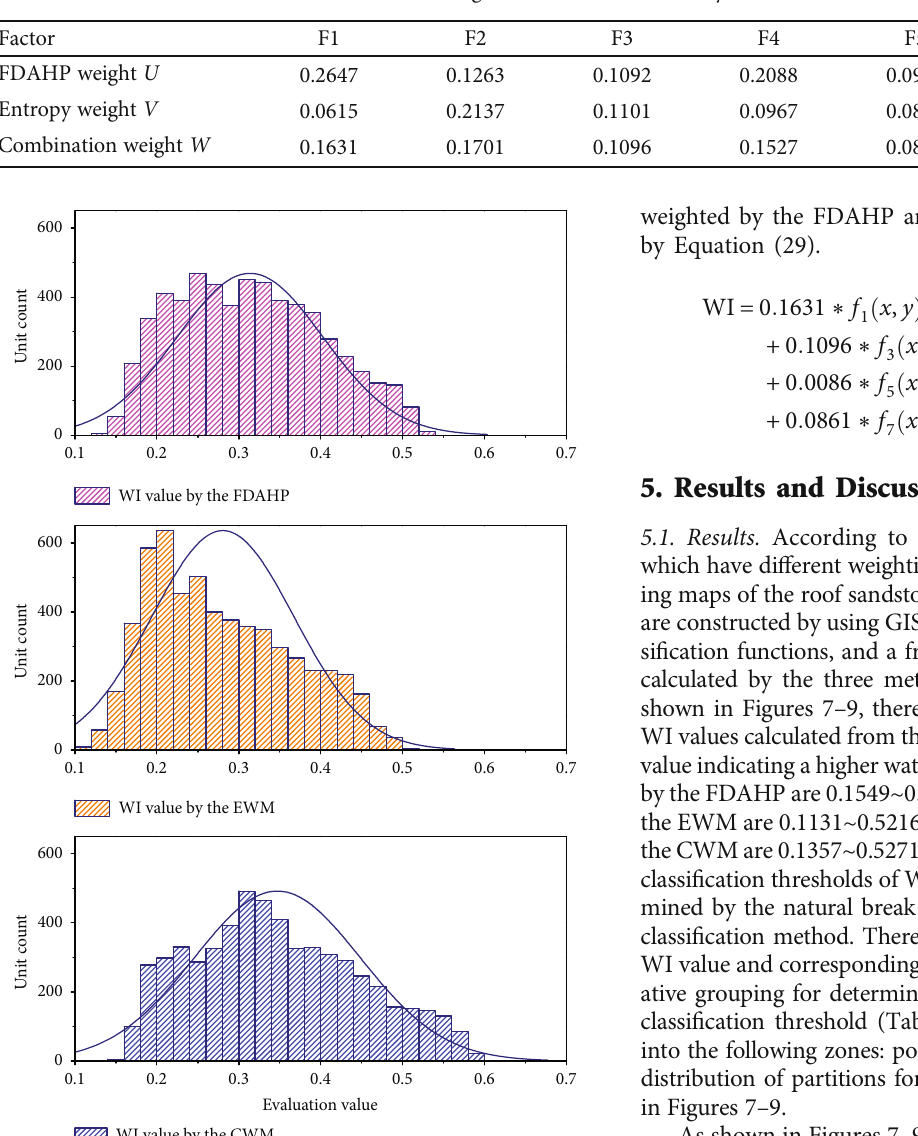
Table 5: The calculated weights of evaluation factors by the FDAHP, EWM, and CWM.